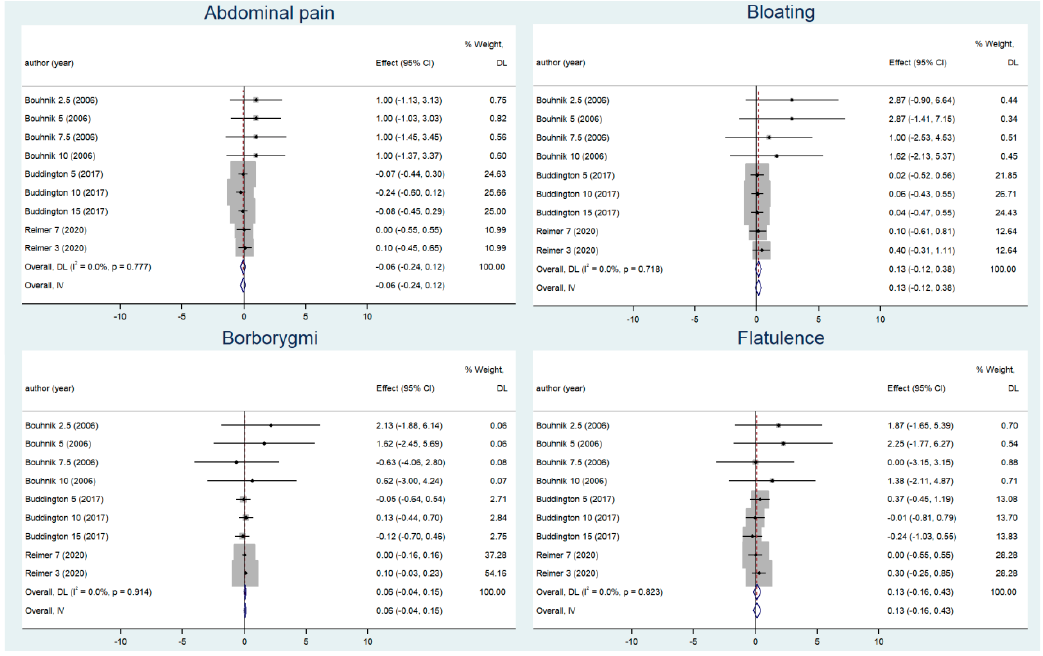
Figure 3. Changes in adverse gastrointestinal reactions before and after supplementation